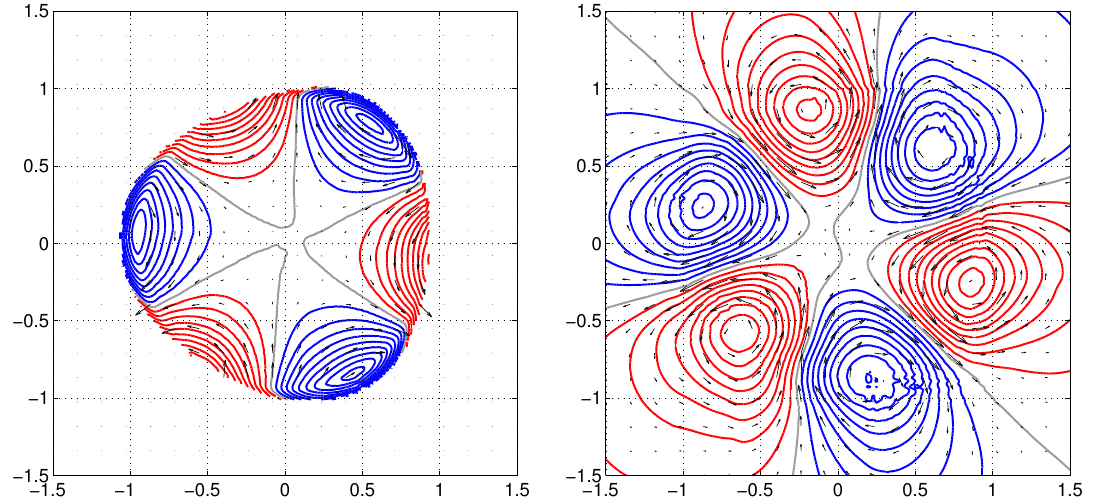
Figure 6. Upper ( left ) and lower ( right ) non-axisymmetric parts of the pressure (lines) and velocity (arrows) at t = 40 f − 1 for the simulation initialized with a m = 3 perturbation in the upper layer. Positive values of the pressure perturbation are in blue and negative values are in